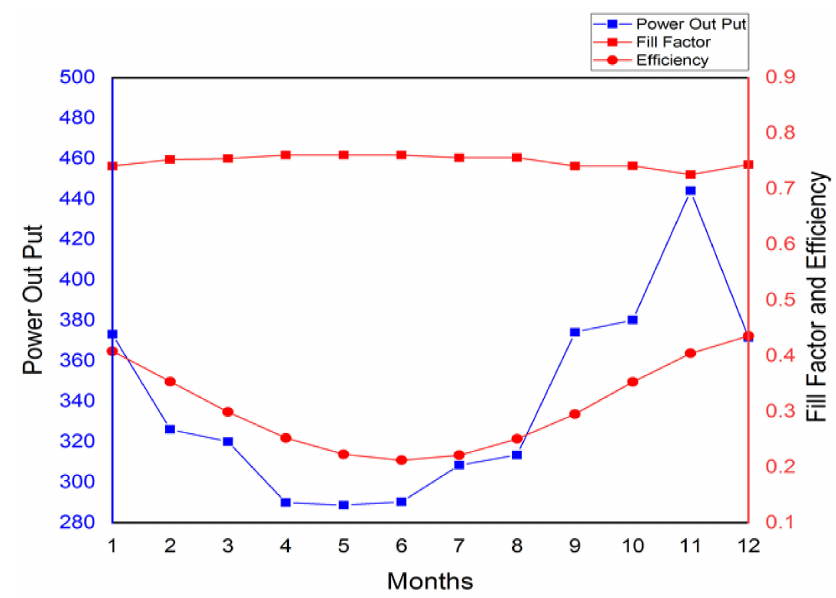
Figure 7. Power, efficiency, and FF at an optimal fixed tilt angle (29.5 ◦ ), by